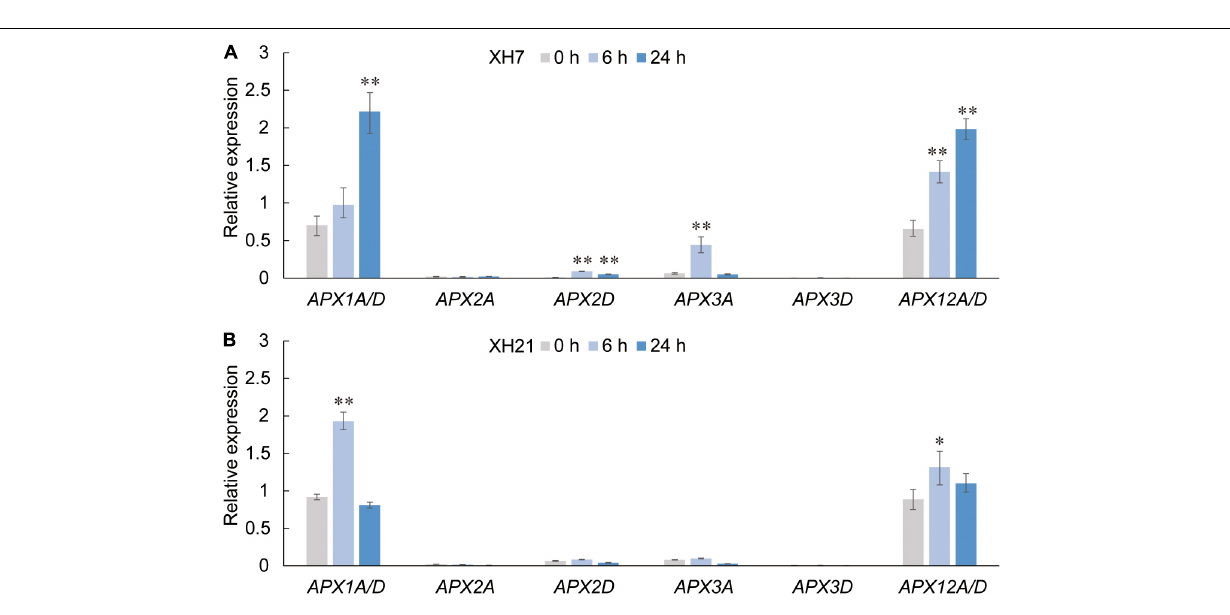
Frontiers in Plant Science |